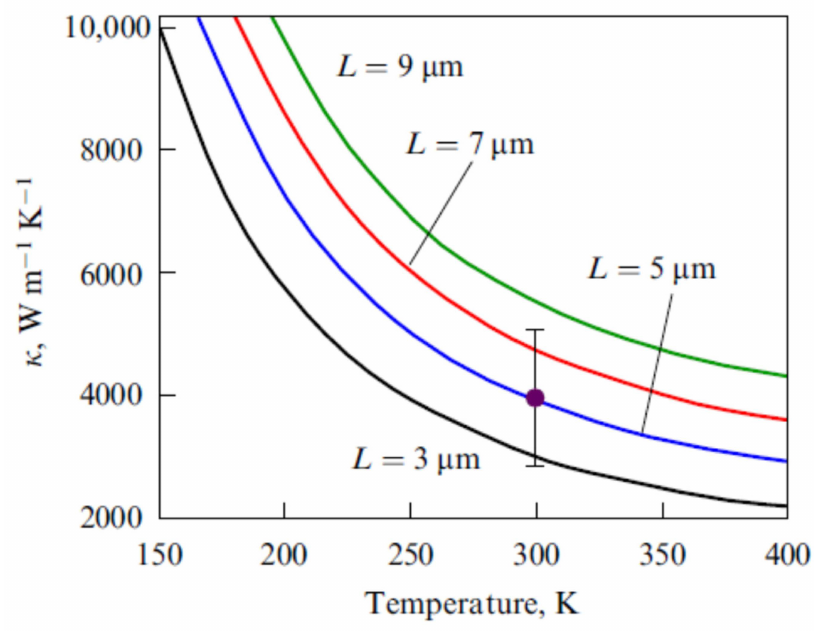
Figure 9. Temperature dependences of the thermal conductivity k of a rectangular defectless graphene sheet of various size